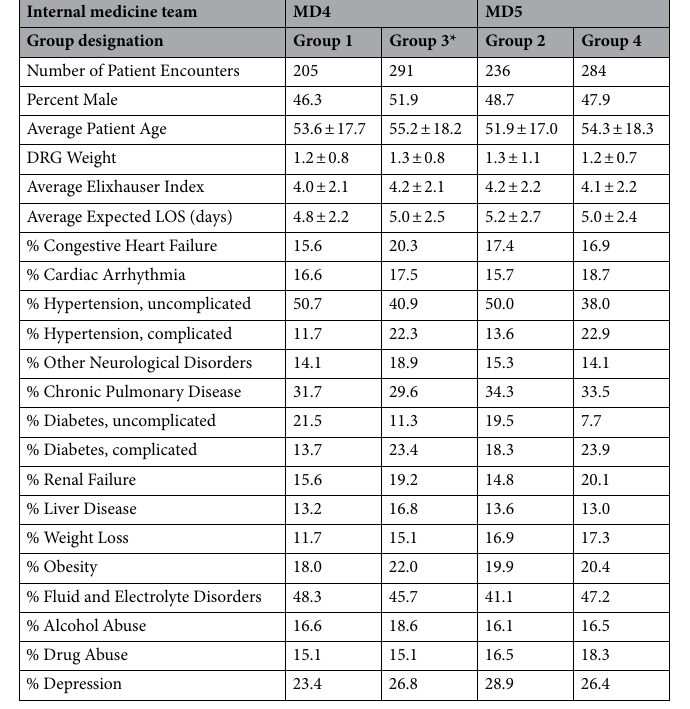
Table 2. Descriptive statistics for all groups. Average Patient Age, DRG Weight, Average Elixhauser Index, and Average Expected LOS display. Mean ± Standard Deviation. Descriptive statistics were not statistically significant between groups. * Designates treatment group.